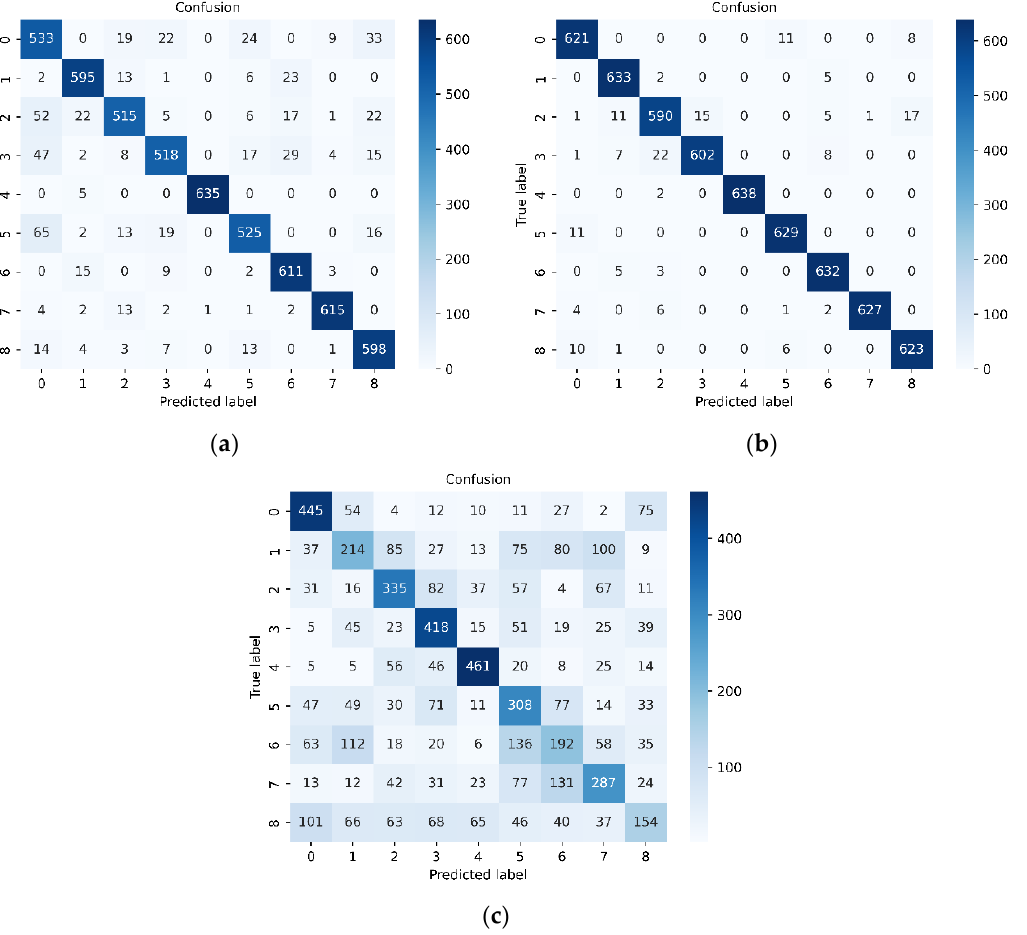
Figure 7. Confusion matrices of the results. ( a ) Confusion matrix without context enhancement. ( b ) Confusion matrix with context enhancement. ( c ) Confusion matrix under context information.